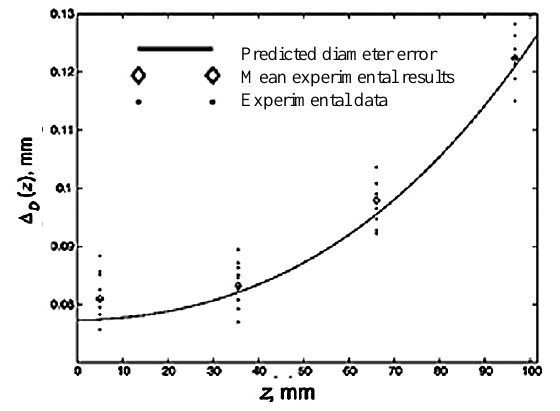
Figure 2. Diametral error of aworkpiece clamped by a chuck in turning [27].